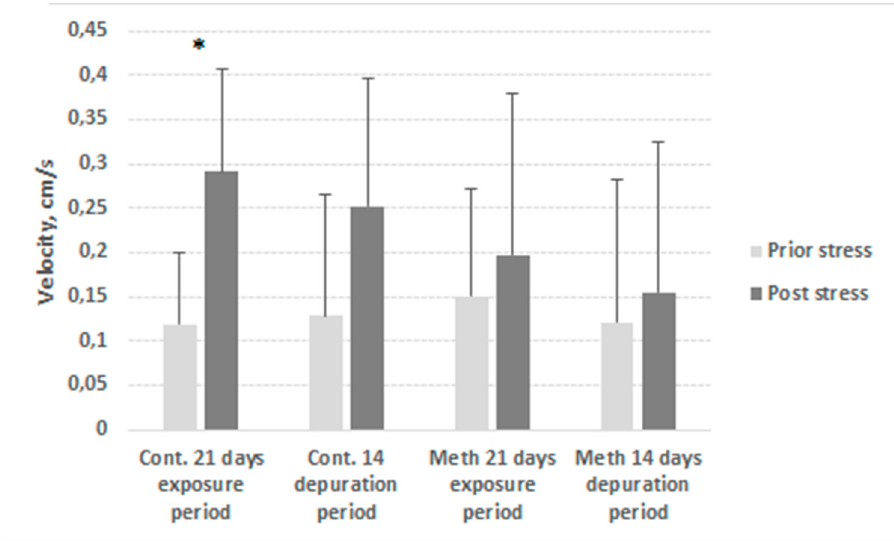
Figure 4. Mean velocity of control (Ctr.) and METH ‐ exposed (Meth) signal crayfish during exposure and depuration (D). Before (light grey) and after (dark grey) stress application. Columns correspond to the means of trials conducted on days 0, 1, 7, 14, and 21 of the 21 ‐ day exposure period (21 days) and on days 1, 2, 7, and 14 of the 14 ‐ day depuration period. Whiskers correspond to standard deviation; n = 12 in each trial. * indicates significant difference ( p < 0.05).